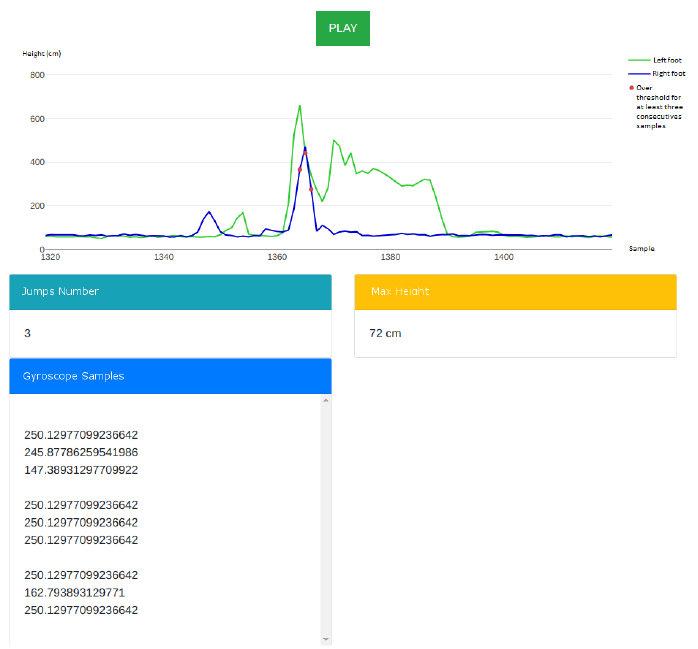
Figure 4. The web-based GUI. The graph shows jump heights sampled in real time by the